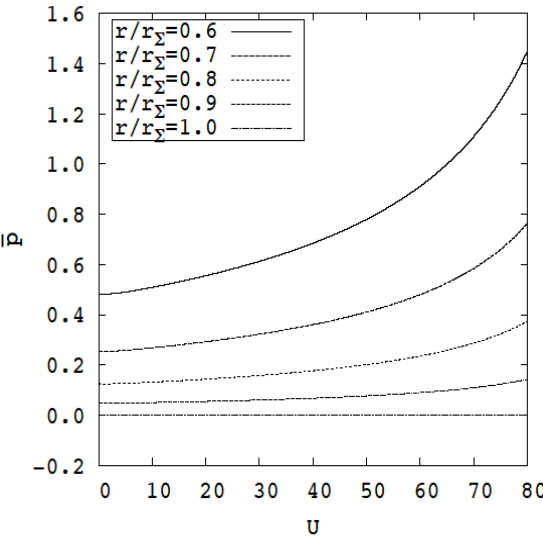
Figure 4. Changes in the matter density with time in different layers (multiplied by 10 2 ).